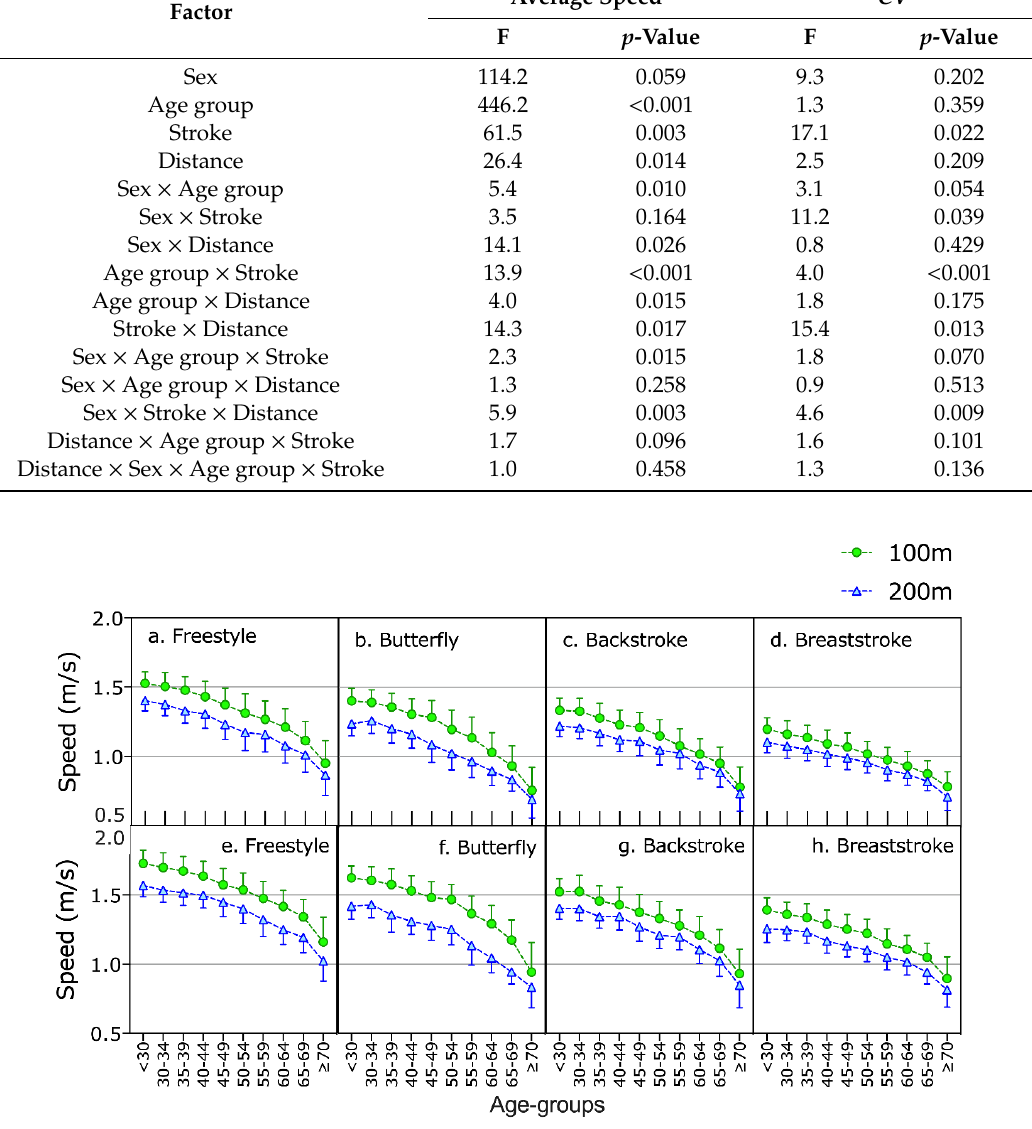
Figure 1. Swimming speed of women ( a – d ) and men ( e – h ) in 100 m and 200 m of the four strokes across age groups.